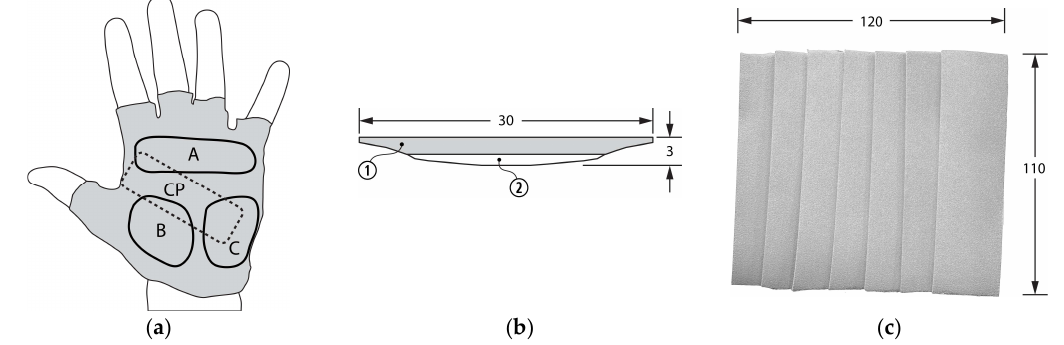
Figure 2. ( a ) Palm side of tested gloves model with identification of padded areas (A, B, C) and of the contact patch between the glove and the instrumented brake hoods (CP); ( b ) Bar tape cross-section. 1 -ethylene-vinyl acetate (EVA) foam; 2 -elastomer gel layer; ( c ) Handlebar tape strips arrangement. Note: All dimensions are in